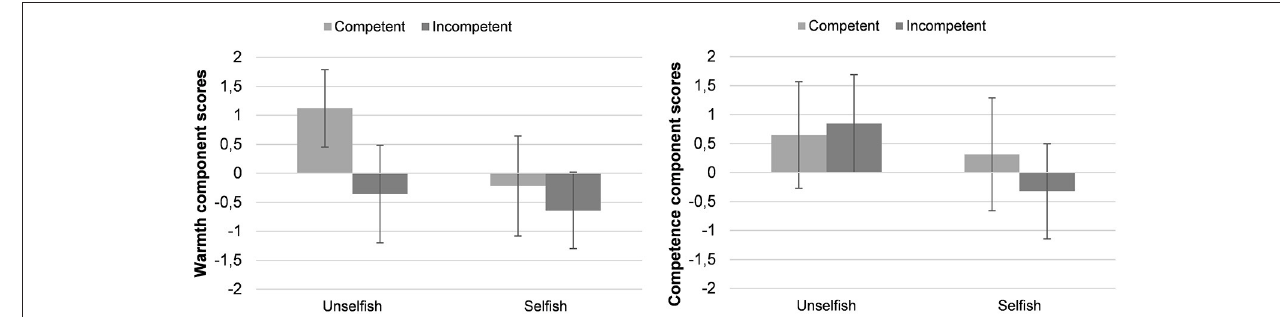
FIGURE 2 | Perceived warmth and competence means. Error bars represent standard deviations.